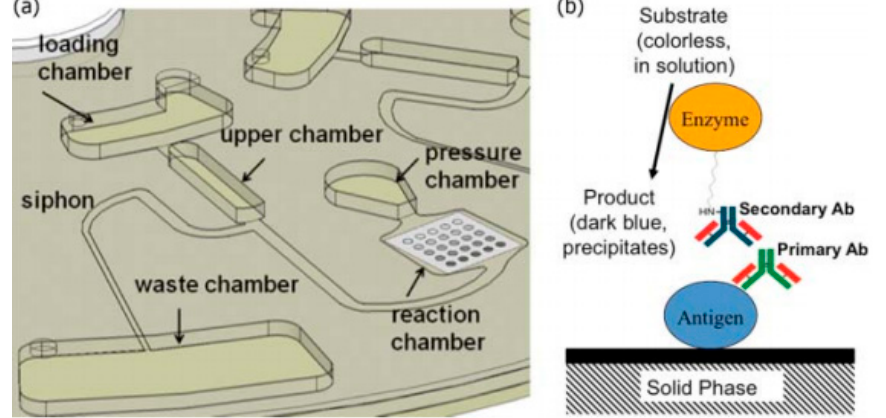
Figure 6. ( a ) Schematic of fluidic system composed of a series of hydrophobic and capillary valves. The siphon valve, along with a reciprocating spin protocol, was used to expose the sample to the reaction chamber for detection; ( b ) Schematic of antibody capture at each array element in the reaction chamber. Reprinted with permission from the American Institute of Physics [30].